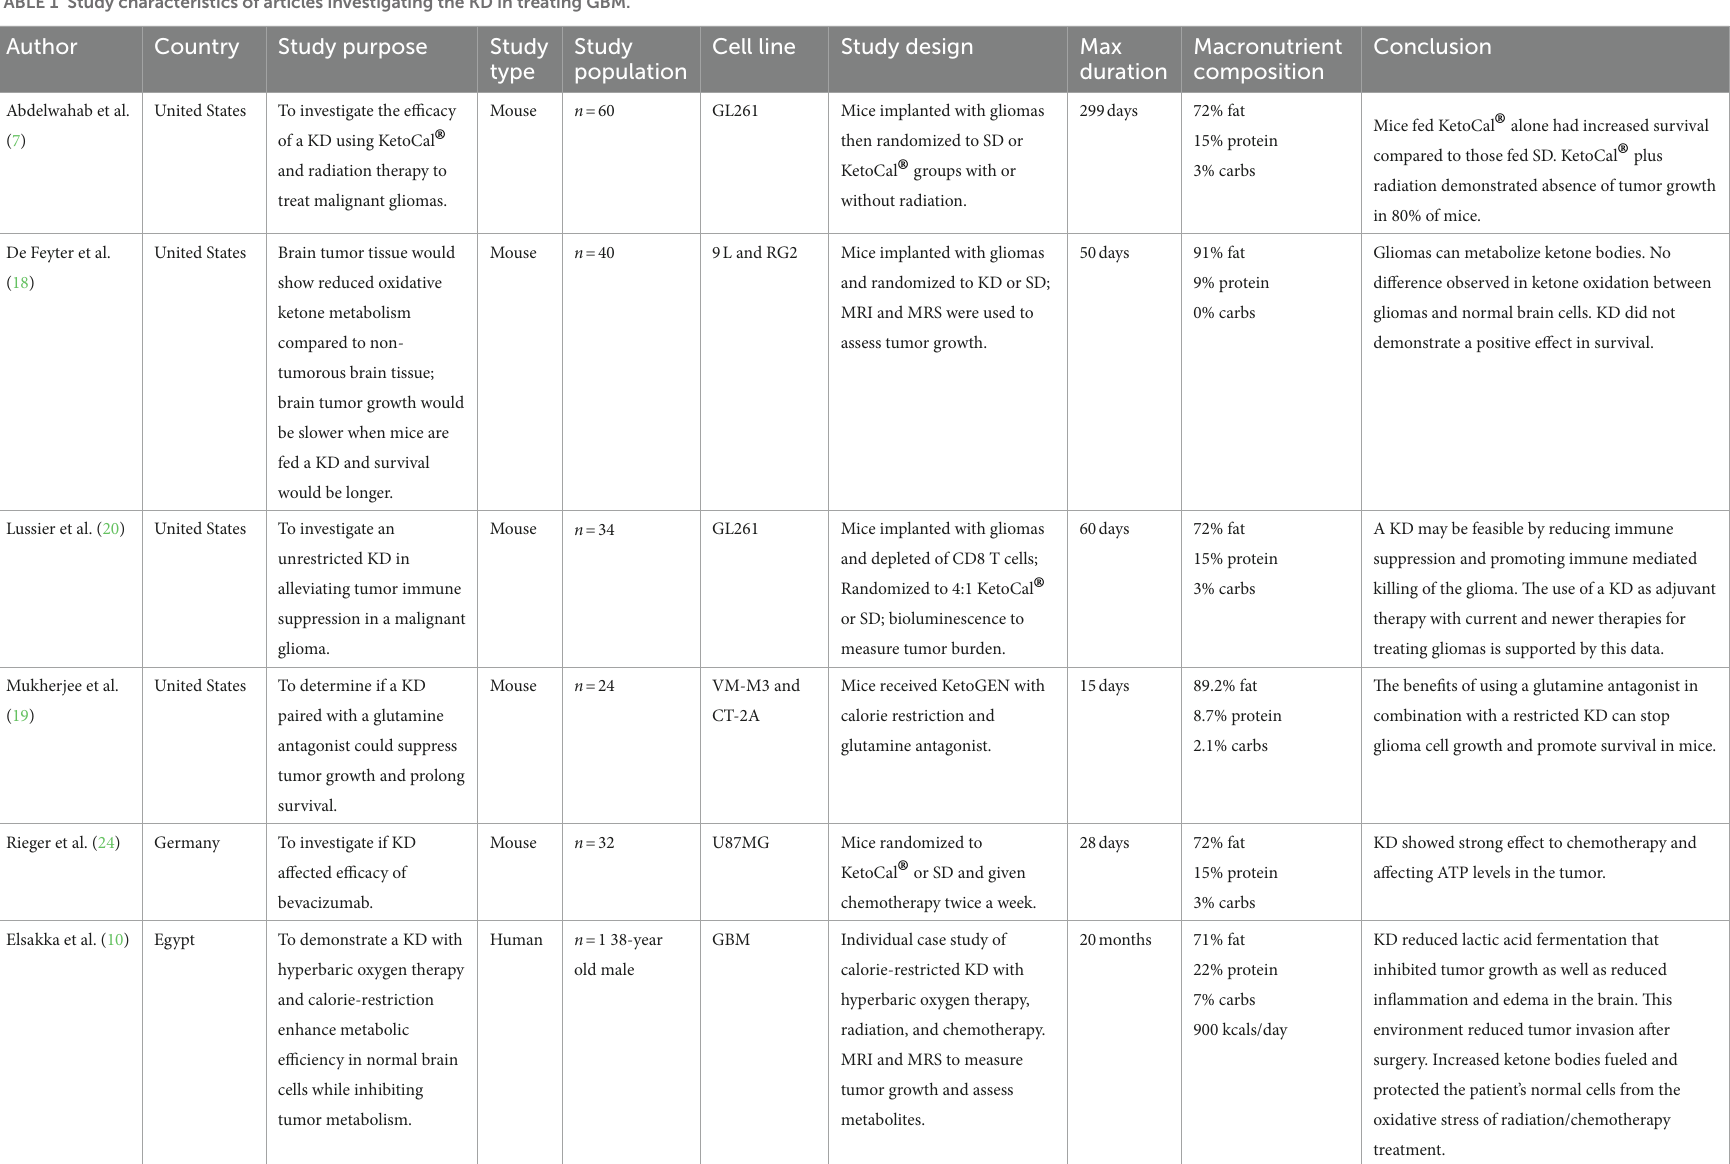
TABLE 1 Study characteristics of articles investigating the KD in treating